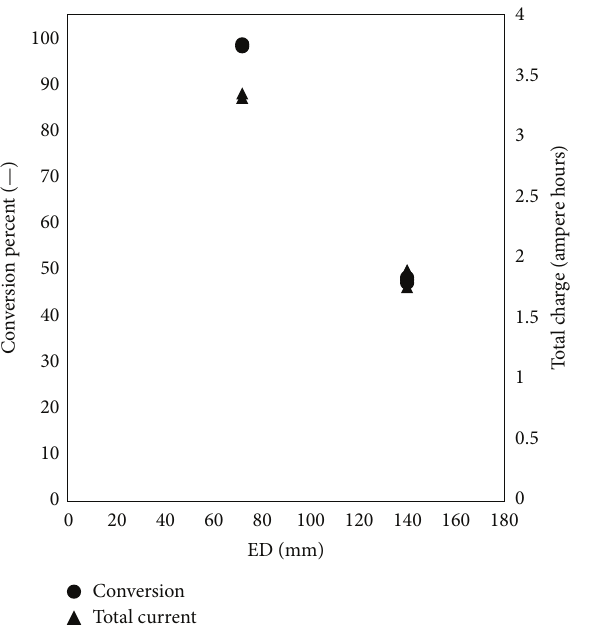
Figure 13: Current efficiency percent (—) versus voltage (volts) for ED of 0.072